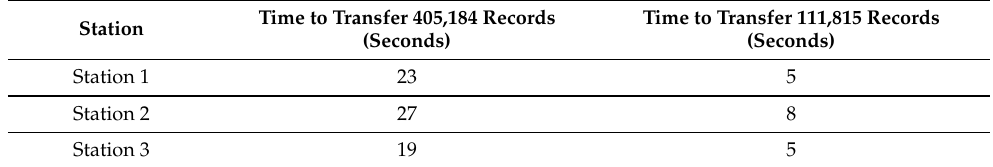
Table 6. Number of records and communication